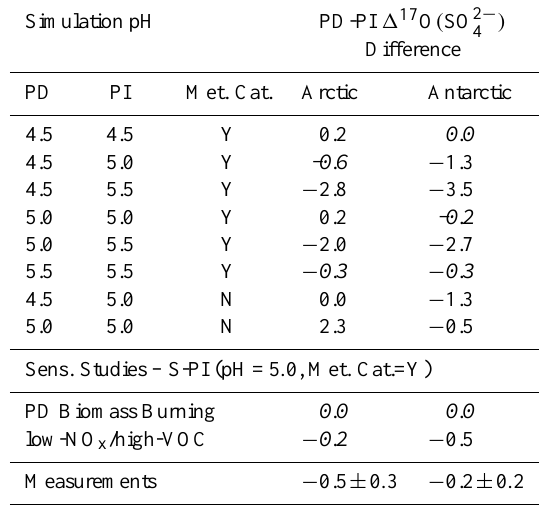
Table 3. The percent (%) of non-sea salt sulfate formed by each oxi- ) between PD and PI simula- Table 2. Difference in 1 17 O ( SO 2 − 4 dation pathway in the Arctic (Site-A, Greenland and Alert, Canada) tions (PD-PI). Sensitivity studies assume a cloud-water pH of 5.0 and Antarctic (WAIS-Divide). The PI simulation shown here is con- and are compared to the PI simulation run at a pH of 5.0. Bold- ducted at a cloud water pH of 5.0. The PD simulation assumes a italics indicate agreement with measurements within the analyti- cloud water pH of 4.5 in the Northern Hemisphere and 5.0 in the cal uncertainty of the measurements. From the ten-year simula- Southern Hemisphere. The ten-year interannual variability (1 σ ) is tions, the 1 σ interannual variability in the modeled PD-PI change ≤± 3% in the Arctic and ≤± 2% in the ) is ± 0 . 2‰ for Site-A/Alert and ± 0 . 03‰ for WAIS- in 1 17 O ( SO 2 − 4 Divide. “Met. Cat.” indicates whether (Y) or not (N) simulations in- clude the metal-catalyzed S(IV) oxidation pathway. Measurements ) from the Arctic (Site-A, of the PD-PI difference in 1 17 O ( SO 2 − 4 Greenland and Alert, Canada) and the Antarctic (WAIS-Divide) are also shown.